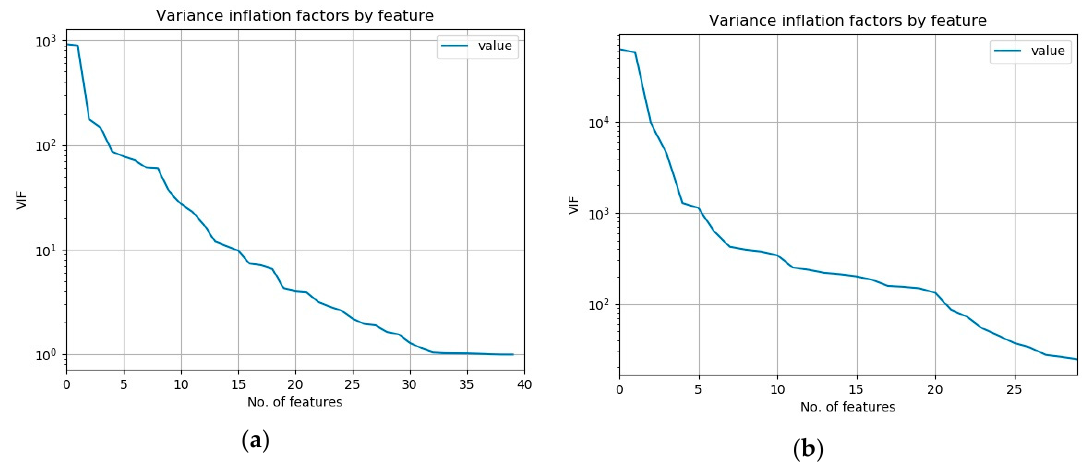
Figure 3. Values of variable inflation factors (VIF) of all features, ordered by their value in descending order: ( a ) from the NSL-KDD dataset; ( b ) from the UCI-BCW dataset. VIF is displayed on a logarithmic scale.